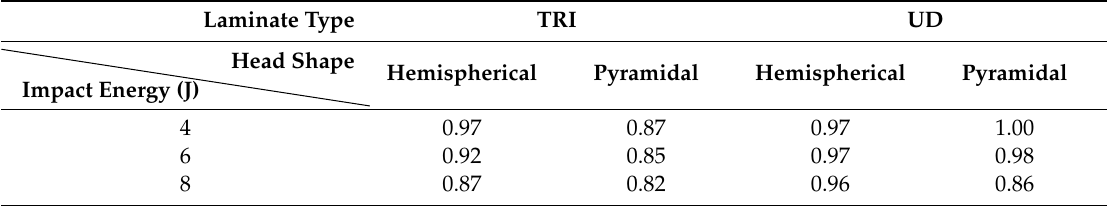
Table 3. Residual tensile strength reduction ratio for the impacted UD and TRI GFRP